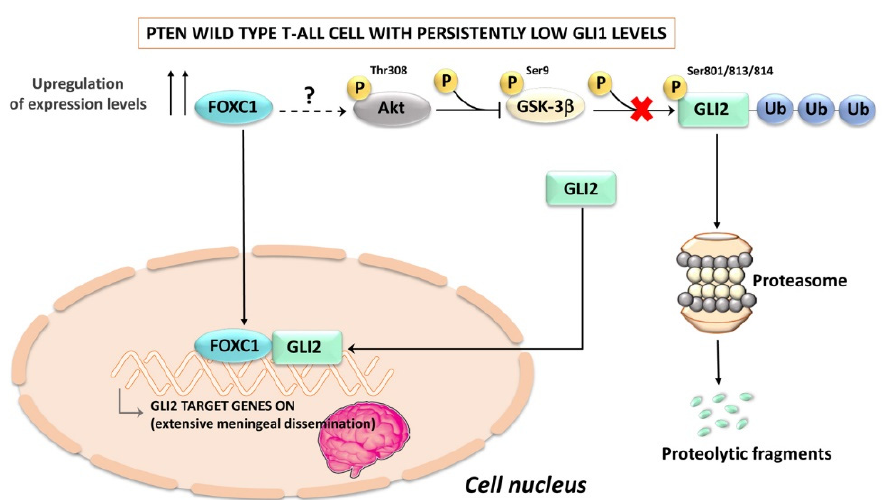
Figure 5. Persistently low GLI levels result in upregulation of GLI2 via FOXC1 in PTEN wild-type T-ALL cells. The schematic cartoon illustrates a possible mechanism of GLI2 upregulation via FOXC1/Akt/GSK-3 β signaling. Upregulated FOXC1 activates Akt through a still undefined mechanism. Active Akt phosphorylates GSK-3 β at Ser 9, thereby inhibiting GSK-3 β which cannot target GLI2 for ubiquitination and proteasomal degradation. GLI2 translocates to the nucleus, where it upregulates a specific transcriptional program, resulting in extensive leukemic